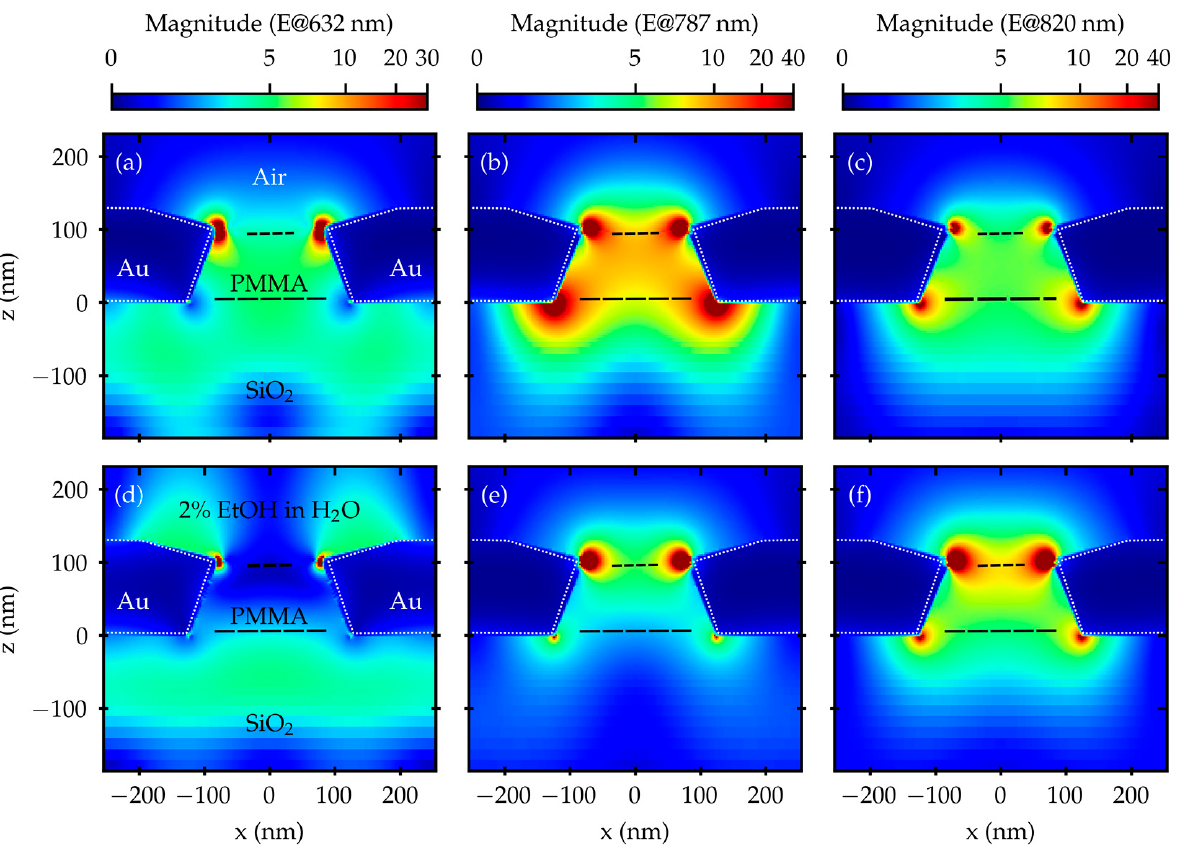
Figure 6. Electric field expansion calculated in the x–z plane at 632 nm, in panels ( a , d ), at 787 nm, in panels ( b , e ), and at 820 nm, in panels ( c , f ). For panels ( a – c ), the surrounding medium is air ( n = 1.000), while in panels ( d – f ), it is 2% EtOH in water solution ( n = 1.334).